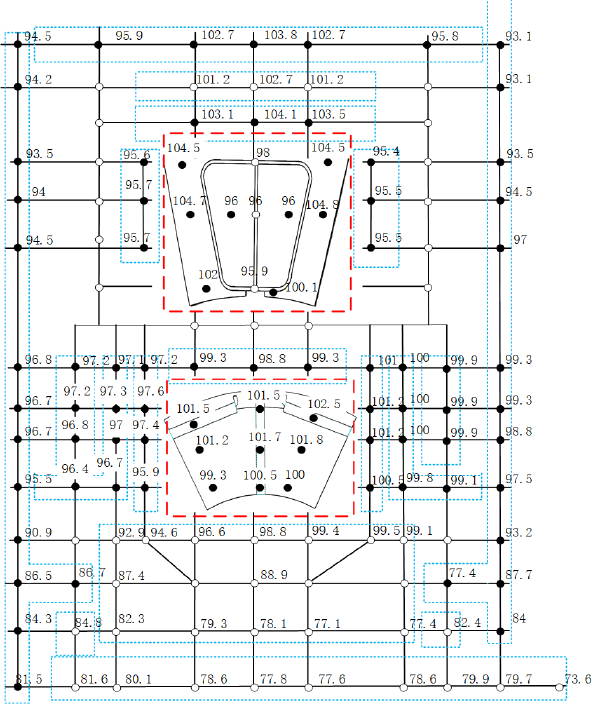
Figure 10. 3D thermal network temperature distribution diagram of DHEG.